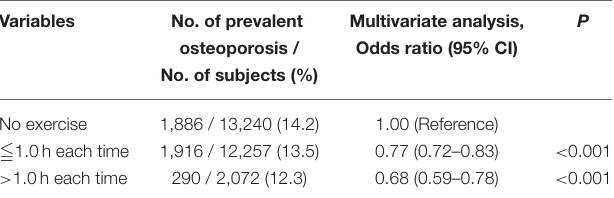
TABLE 3 | Odds of osteoporosis at baseline in the cross-sectional cohort according to the time of exercise ( N = 29,775, excluding 271 subjects without data at hours per exercise